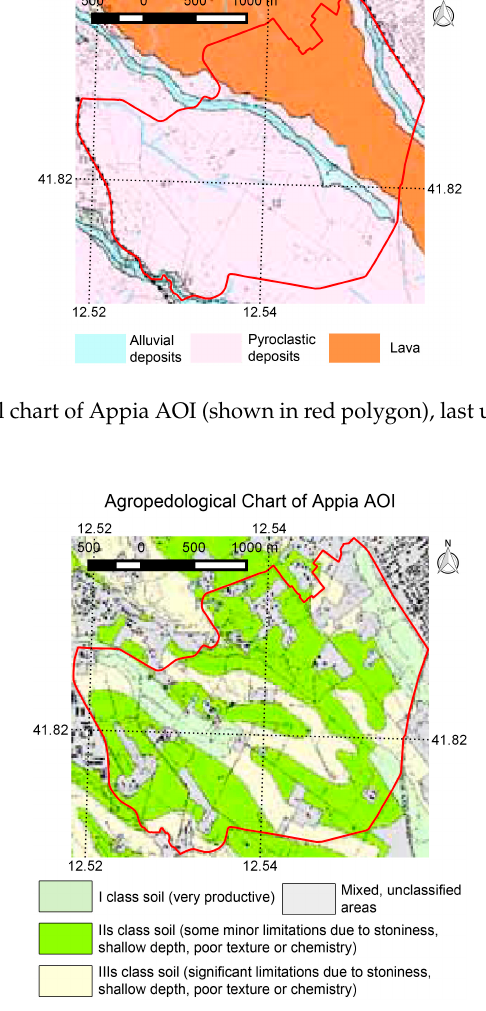
Figure 22. Agropedological chart of Appia AOI (shown in red polygon), last updated in 2007. Copyright: Comune di Roma [73].